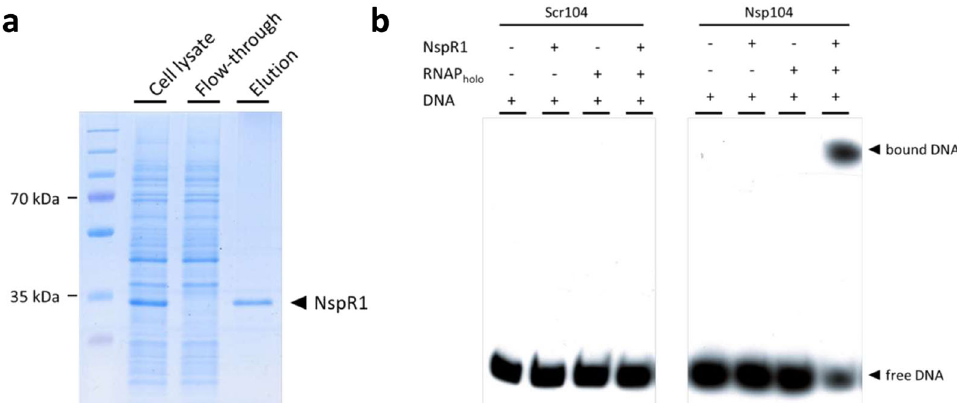
Fig. 5 Puri fi cation and DNA-binding of NspR1. Puri fi cation of soluble NspR1 using Ni-NTA column ( a ). Soluble 6xHis-tagged NspR1 was obtained by overexpressing the protein in the presence of 5 μ M C8-HSL at 17 °C for 16 h. DNA-binding of puri fi ed NspR1 to the DNA probe containing Nspbox1 sequence, Nsp104 and scramble control Scr104, in the presence and absence of E. coli RNA polymerase holoenzyme ( b ). The EMSA gel for both Scr104 and Nsp104 samples were derived from the same experiment and then they were processed in